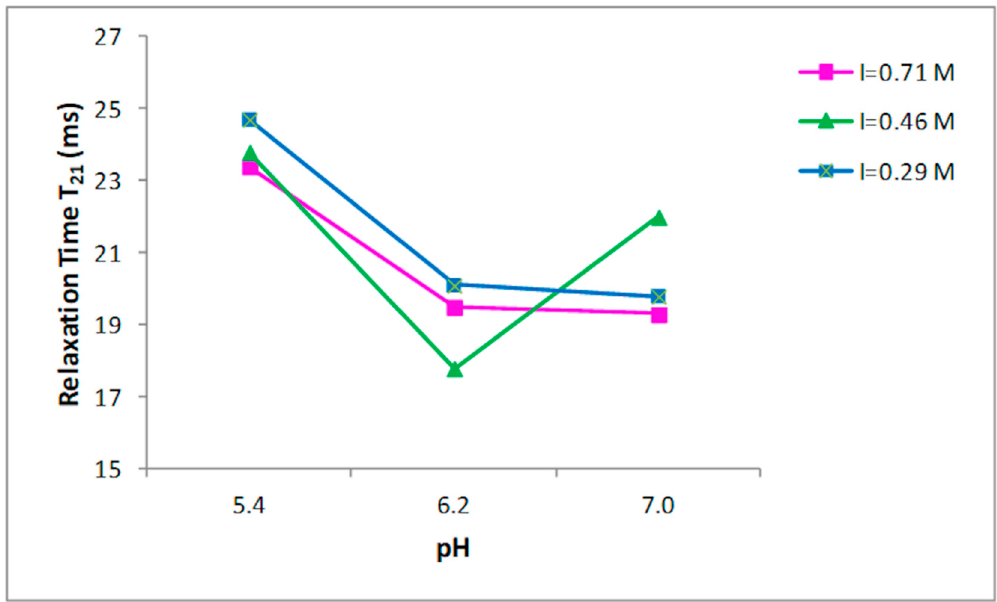
Figure 2. Relationship between the pH and T 21 relaxation time in collagen at different ionic strengths.